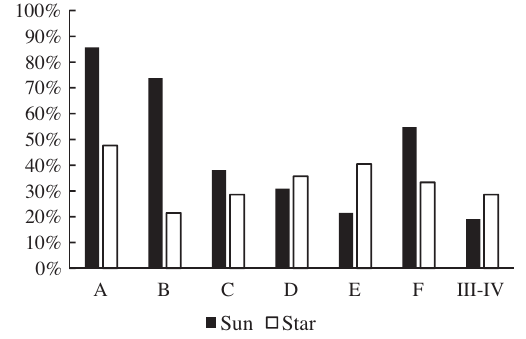
FIG. 3. Percentage of the secondary school students with a correct answer on the Sun and star questions.